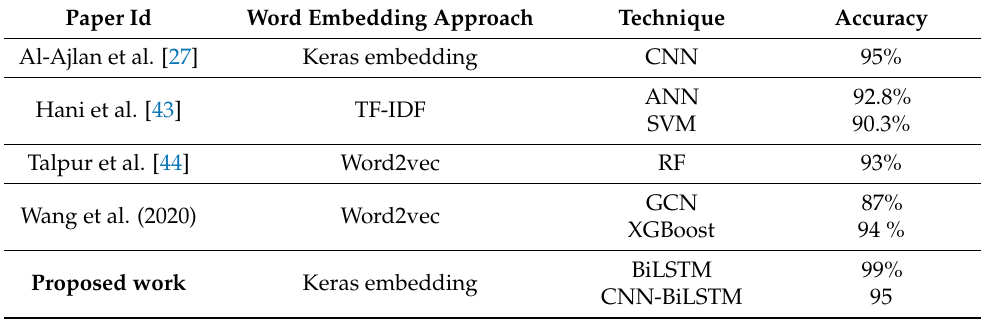
Table 5. Comparison the results of the proposed deep learning models with existing